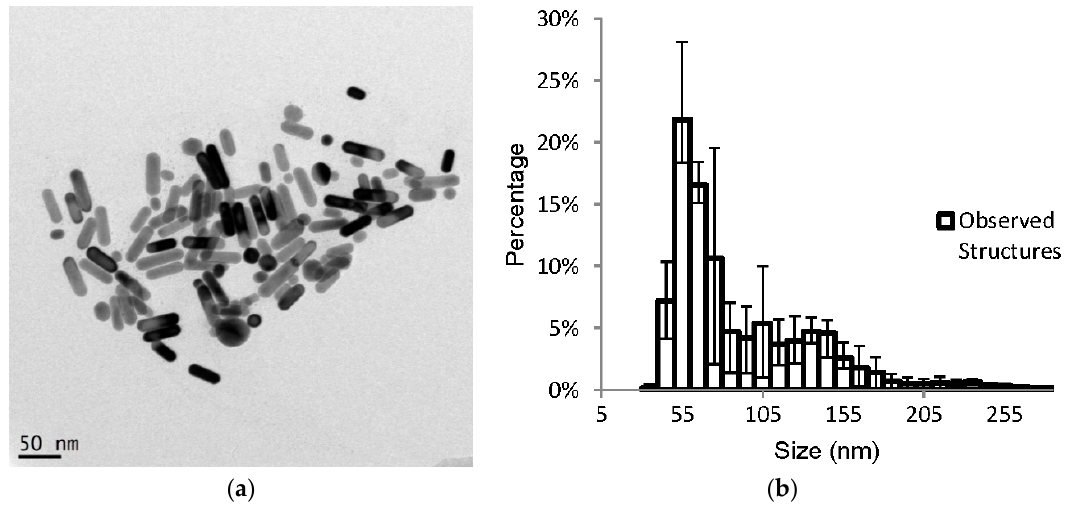
Figure 4. ( a ) Transmission electron microscopy (TEM) and ( b ) dynamic light scattering (DLS) measurements of the GNRs, with an original concentration of 5.20 × 10 (cid:2869)(cid:2869) GNRs/mL.